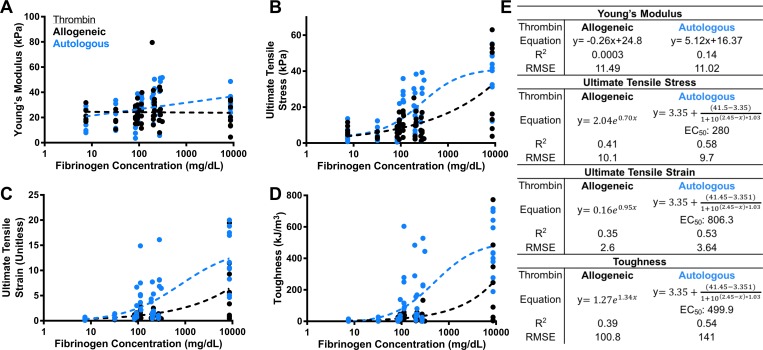
Failure properties improve with increased fibrinogen concentration.Young’s Modulus (A) and failure properties (B-D) plotted as functions of fibrinogen concentration. Strains are unitless. Fibrin sealants fabricated from allogeneic thrombin shown in black, and those fabricated from autologous thrombin shown in blue. Each individual sample represented by a data point. Fit parameters and goodness of fit measurements are summarized in panel (E).